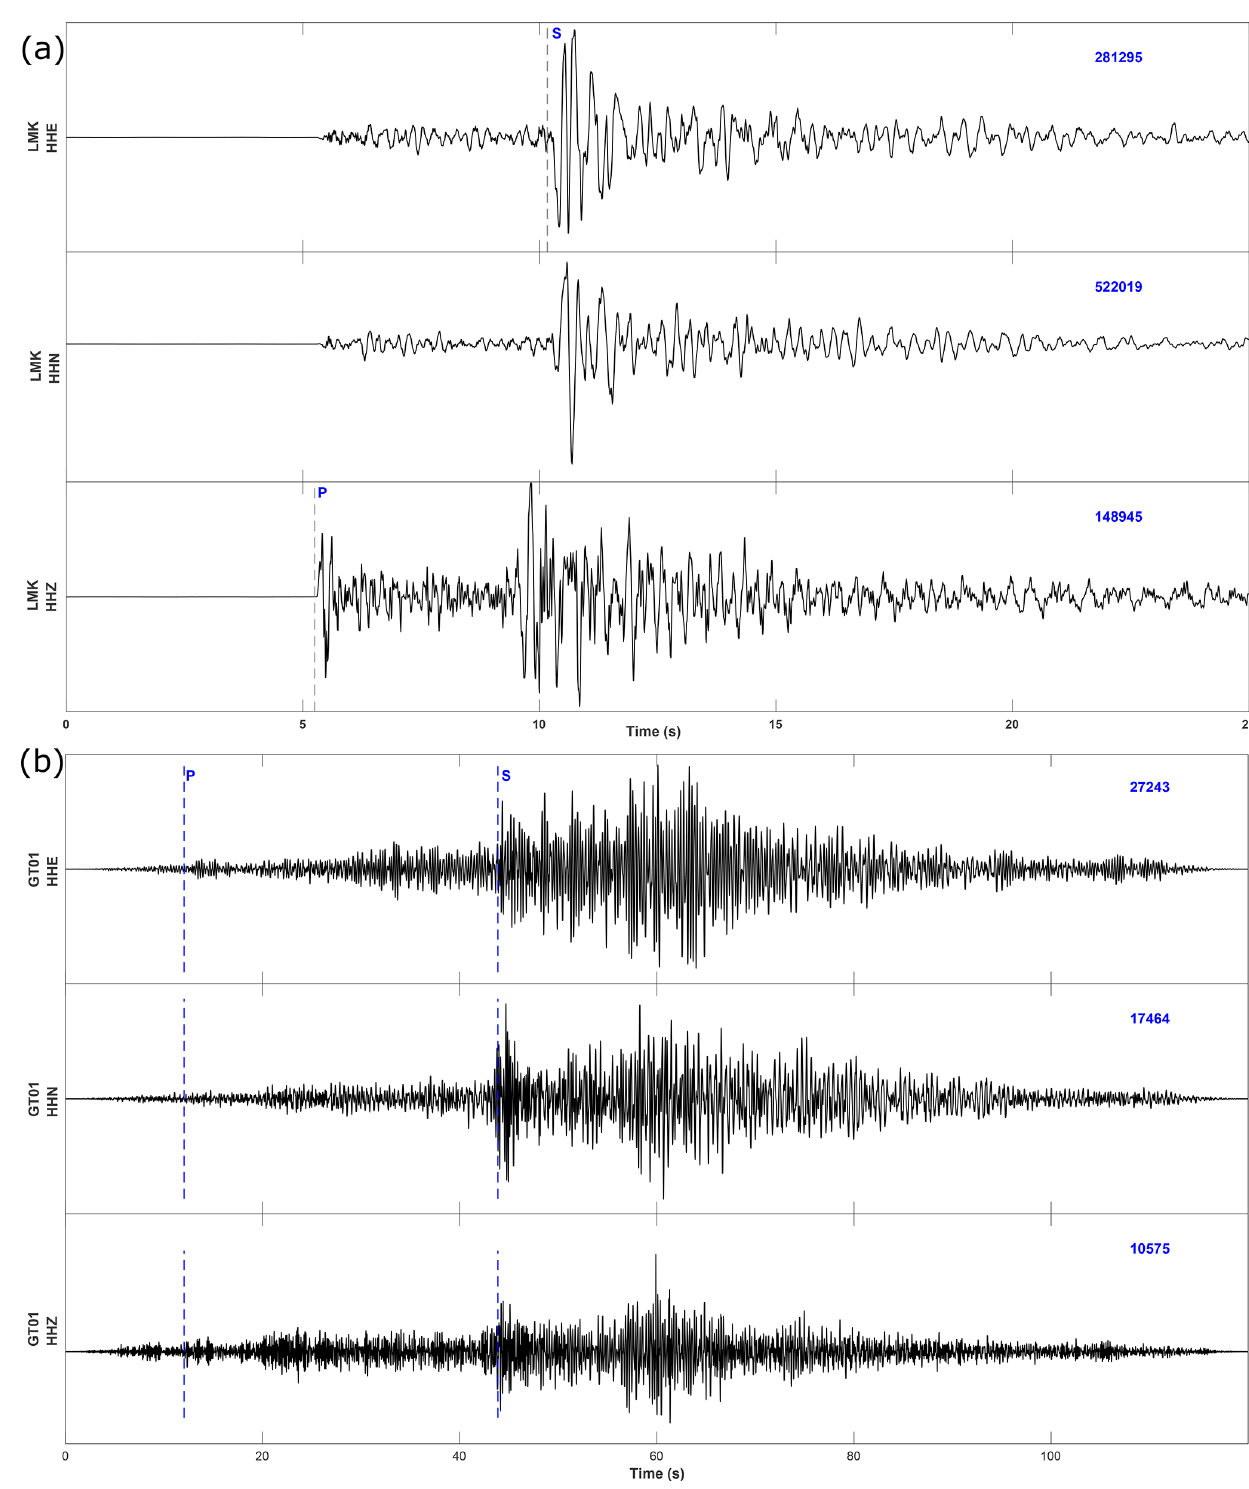
Figure 7. Lincolnshire earthquake (a) as recorded by station LMK ( ∼ 5km from the source) and (b) the later arriving signal at station GT01 in the WMB tower ( ∼ 300km from the source). The HHZ traces show the vertical components of ground motion, and the HHE and HHN traces show the horizontal components, which are oriented E–W and N–S, respectively. Note the difference between signal duration on both seismometers as well as the difference in peak amplitude given by the numbers in blue in the top right corner of each trace. The estimated arrivals of the P and S waves are indicated on both plots. Note that the zero time in each case is arbitrary and the timescale is different for the two